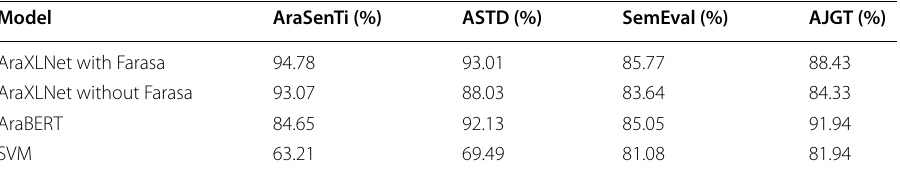
Table 12 AraXLNet compared with AraBERT and SVM